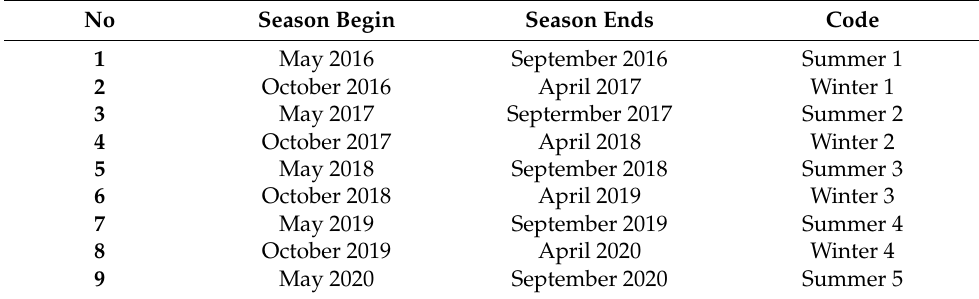
Table 3. Temporal classification of the